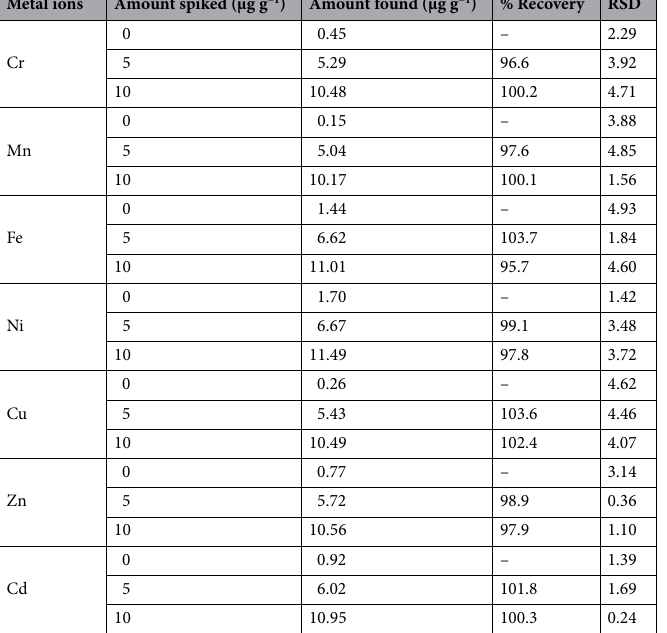
Table 1. Shows percent (%) recovery and relative standard deviation. Blank cells indicate real